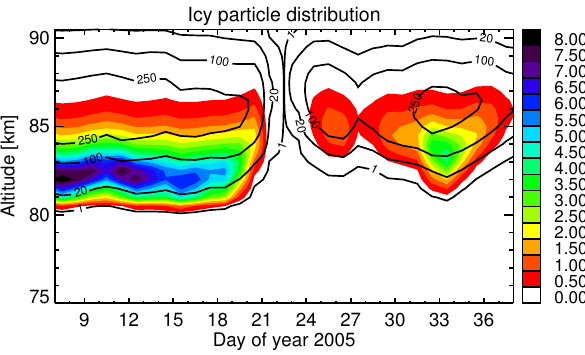
Fig. 5. Modelled icy particles at 75 ◦ S around the SPE January 2005 with MLS temperatures, and without ion chemistry (see text for de- tails). The solid contour lines show the total number of icy particles per cm 3 , and the color contours depict the total ice mass in units of 10 − 15 gcm − 3 . The particles in the smallest radius bin are excluded.